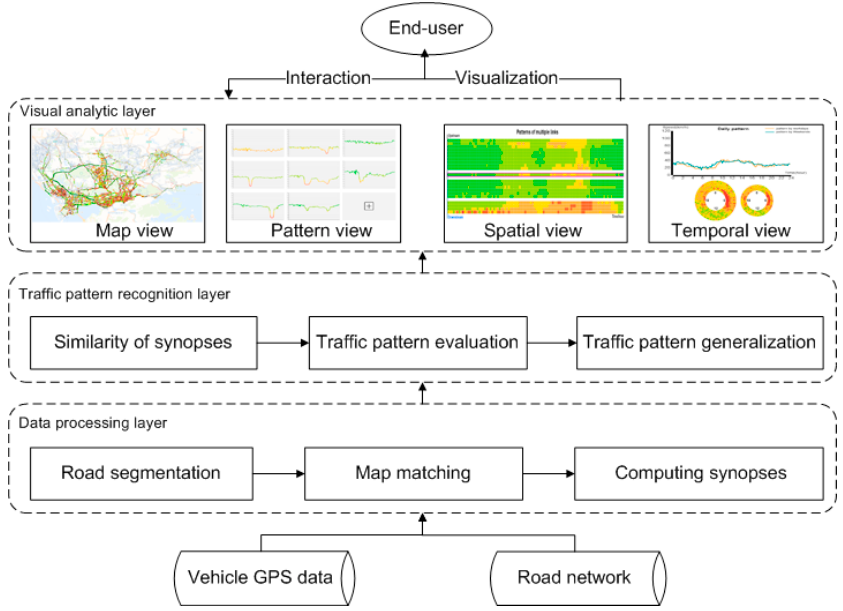
Figure 1. Workflow of the proposed framework.